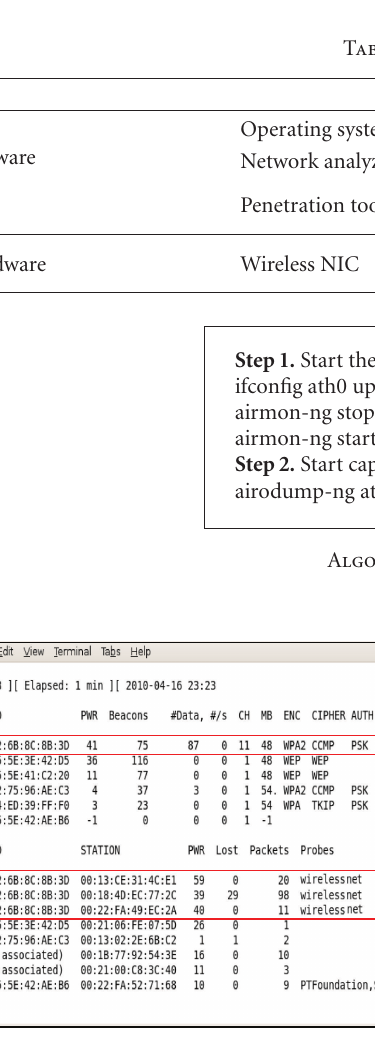
Figure 2: Tra ffi c analyzing